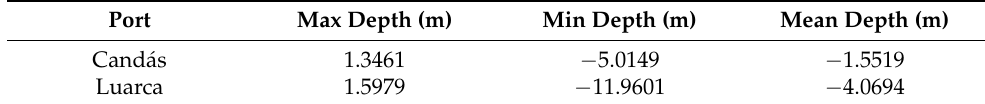
Table 1. Properties depth characteristics of Cand á s and Luarca ports. Port Max Depth (m) Min Depth